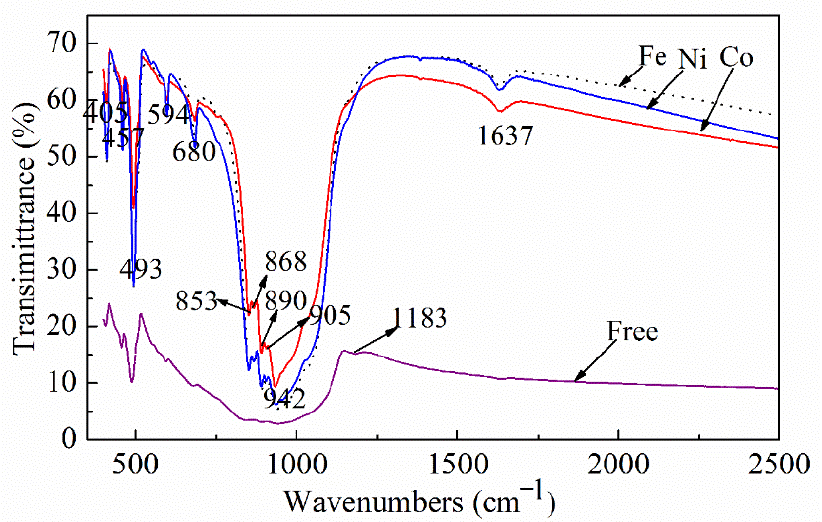
Figure 3. IR spectra of silicon nitride in the samples obtained using various catalysts and the catalyst-free sample.